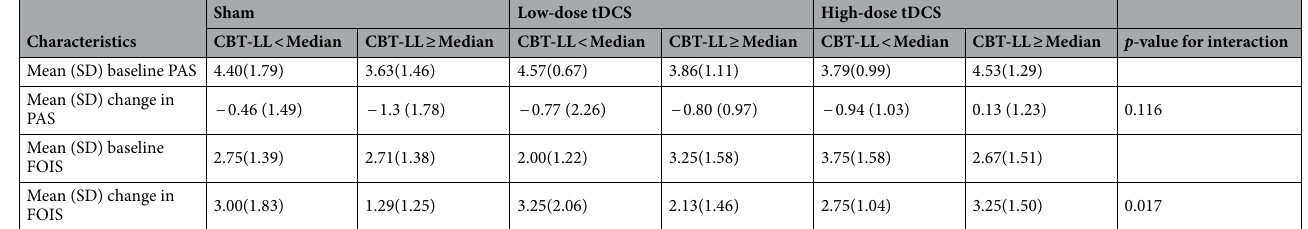
Table 6. Descriptive statistics of penetration-aspiration scale (PAS) and functional oral intake scale (FOIS) with dichotomized corticobulbar tract-lesion load (CBT-LL).